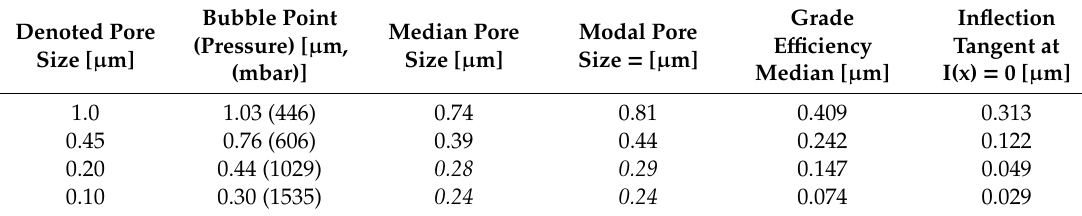
Table 3. Results of membrane characterization studies obtained with pore size meter PSM 165 and polystyrene filtration studies (median grade e ffi ciency and the intercept of the inflection tangent with the x-axis). Hardly reliable values that hit the limit of quantification are represented in